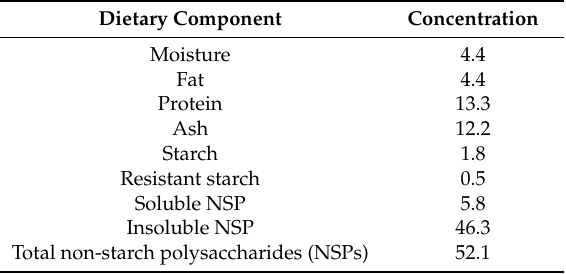
Table 1. Composition of dried green cincau extract (g/100 g dry